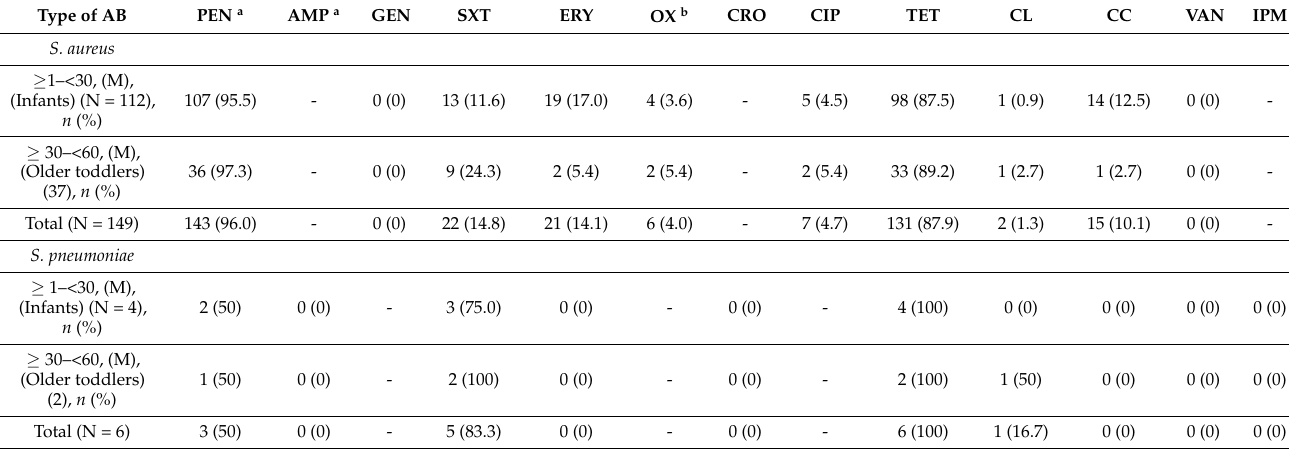
Table 2. The distribution of antibiotic resistance of S. aureus and S. pneumoniae isolated from the children’s nasopharynx according to the different age